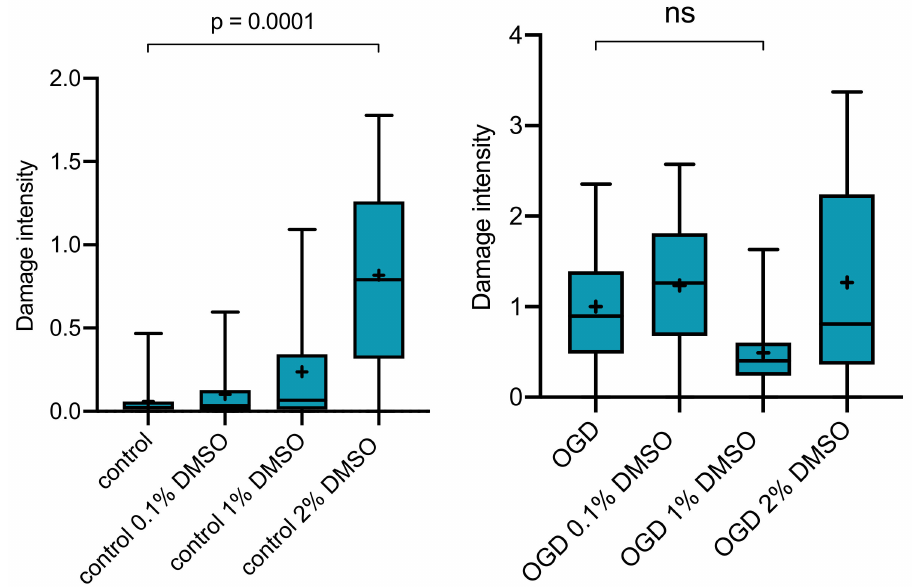
Figure 2. ( Left ): Slices receiving 2.0 Vol.% dimethyl-sulfoxide (DMSO) alone ( n = 20) without undergoing OGD showed significantly ( p = 0.0001) more cell damage. This e ff ect can be observed for 0.1 ( n = 25) and 1.0 Vol.% ( n = 12) as well but at a much lower level without statistical significance. ( Right ): No significant e ff ects of DMSO in slices undergoing OGD were observed for 0.1 ( n = 41), 1.0 ( n = 19) or 2.0 ( n = 45) Vol.% DMSO compared to the OGD group without DMSO ( n = 96). The figure depicts a tendency towards less cell damage at 1.0 Vol.%